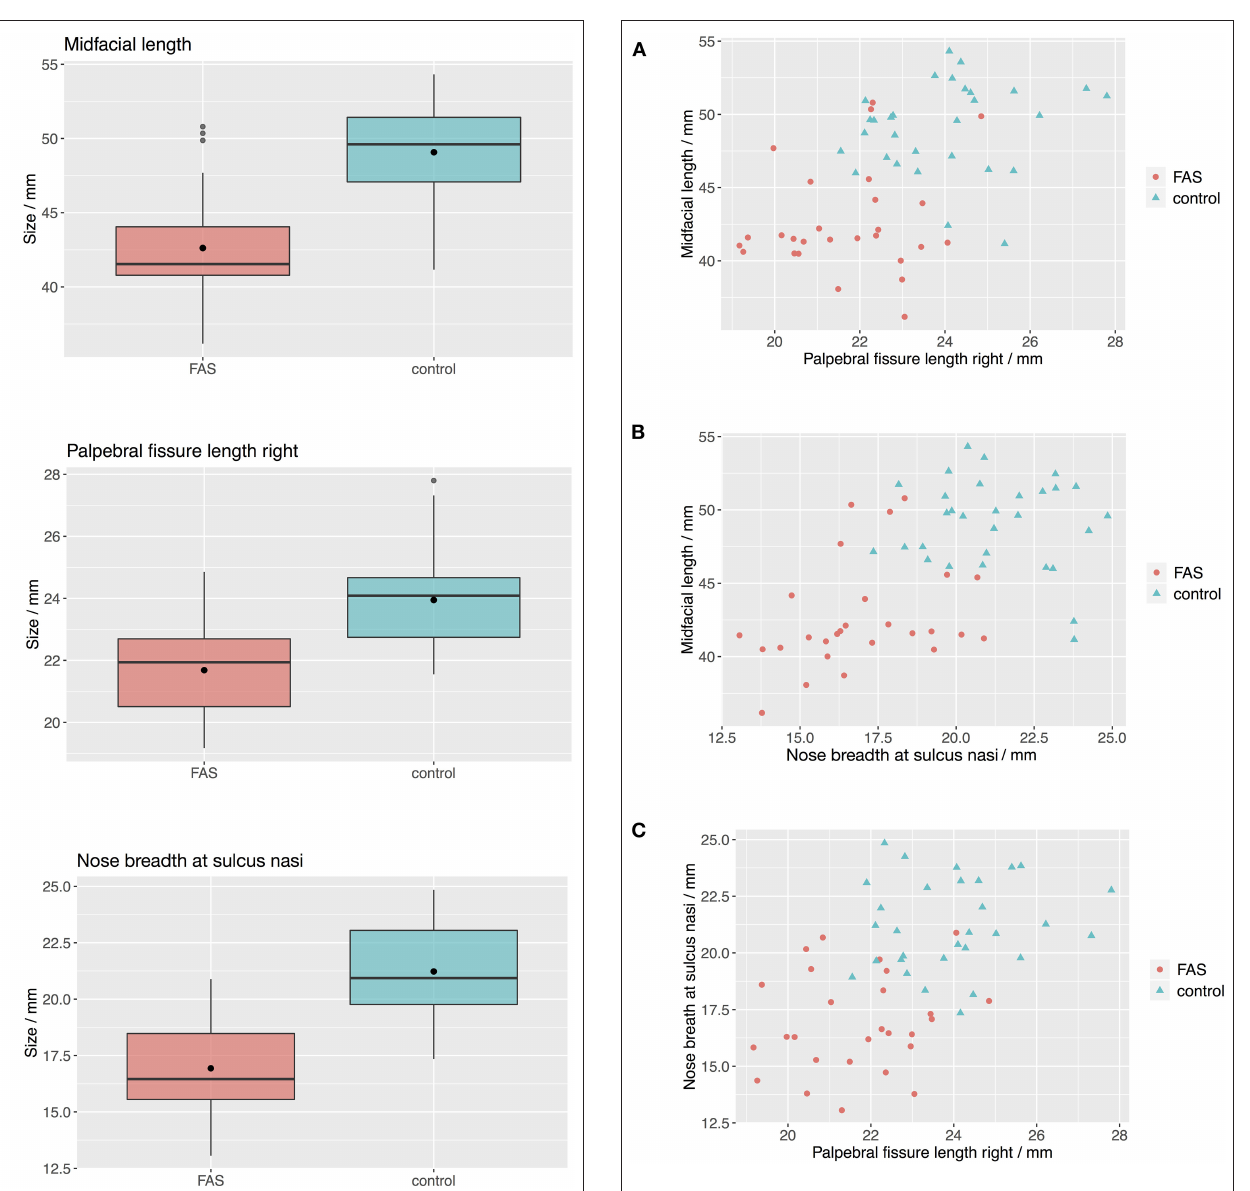
FIGURE 5 | Scatter plots for landmark values. The scatter plots show that a complete division of the values by a trend line is not possible for all combinations of the predictors (A) Palpebral fissure length righ vs. midfacial length, (B) Nose breath at sulcus nasi vs. midfacial length, and (C) Palpebral fissure length right vs. nose breadth at sulcius